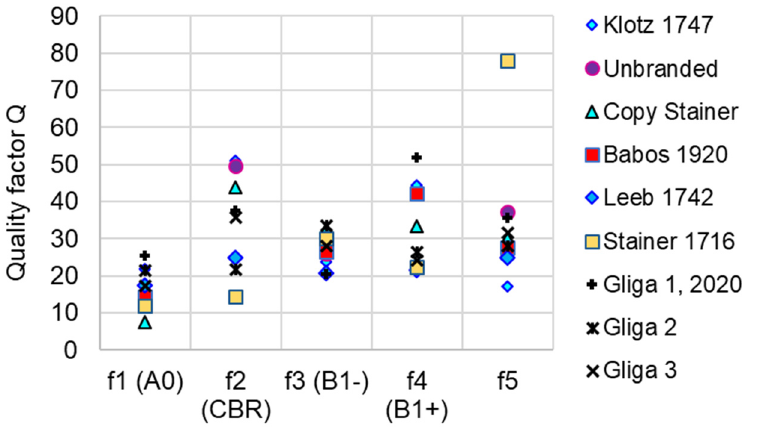
Figure 10. The quality factor variation.